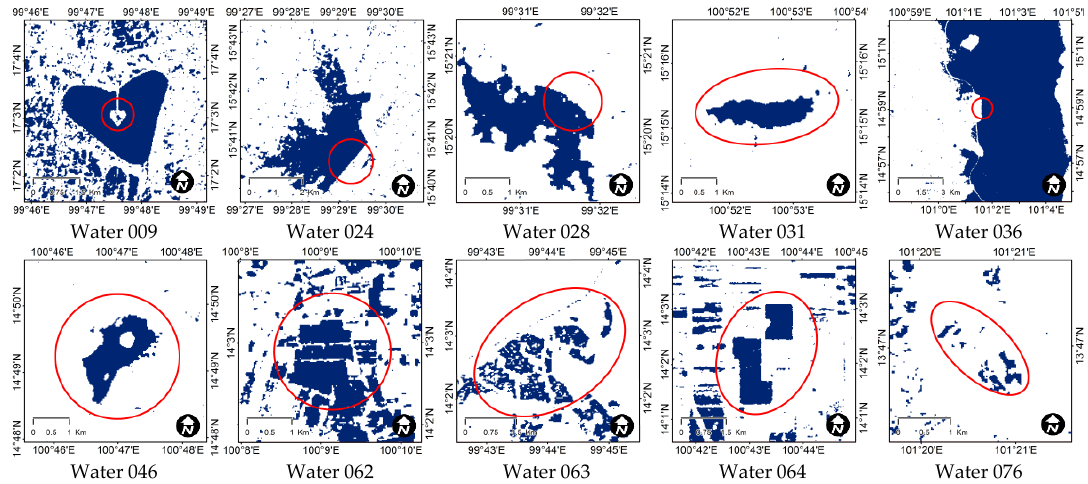
Figure 5. Close-ups of the extracted water extents from the RADARSAT-2 image acquired on Close-ups of the extracted water extents from the RADARSAT-2 image acquired 28 November 2011 using the HH+HV global threshold value (1.92 dB). The water areas are displayed on 28 November 2011 using the HH + HV global threshold value (1.92 dB). The water areas are in deep blue, and the red ellipses are the water references. displayed in deep blue, and the red ellipses are the water